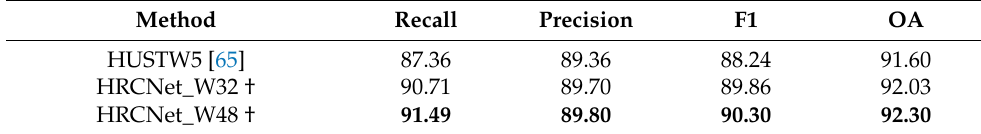
Table 8. Results (%) on the Vaihingen dataset with no boundary, “†” means data augmentation (Flip and Multi-scale (MS) testing) methods.